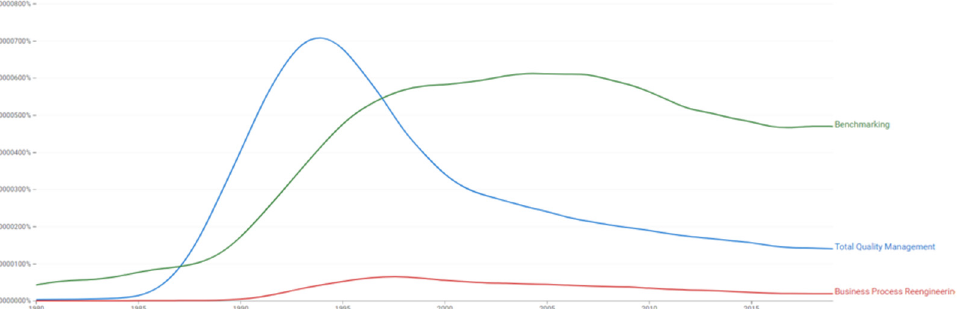
Figure 4. Evolution of the terms “benchmarking”, “total quality management” and “business process reengineering” (Data source: Google Books Ngram Viewer, available at http://books.google.com/ngrams, retrieved 25 August 2022).